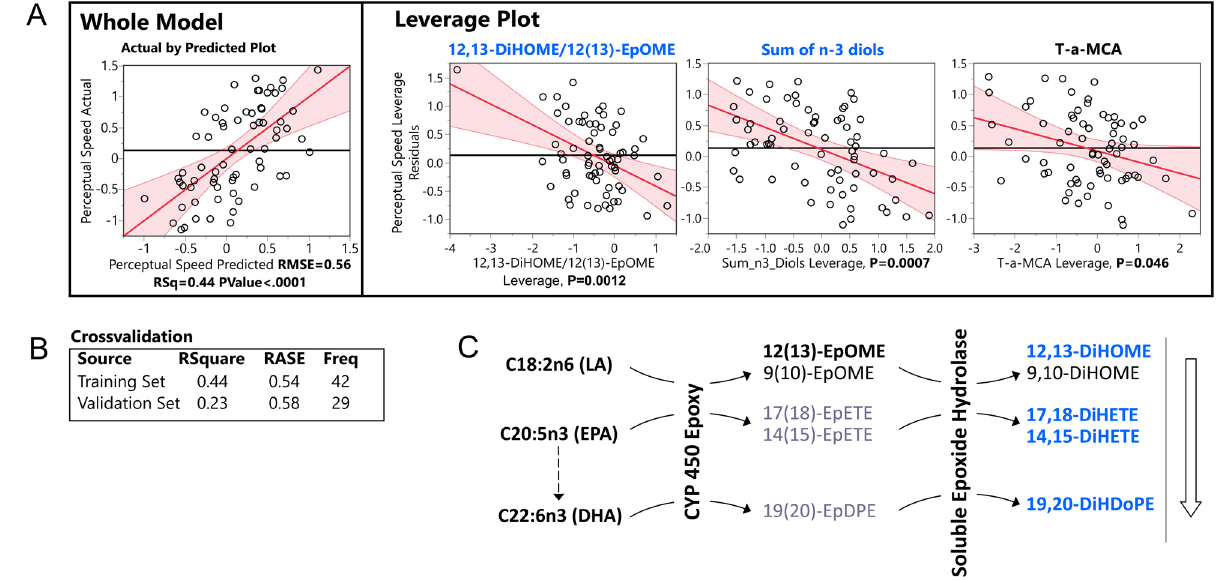
Figure 3. Least square regression model of perceptual speed. ( A ) Actual by predicted plot of a whole model and leverage plots of model components. ( B ) Model cross-validation statistics using training set (60%, n = 44) and validation set (40%, n = 33). ( C ) Model components of soluble epoxide hydrolase metabolism projected onto their metabolic pathway. Metabolic pathway starts with the fatty acids on the left, farther, metabolizing enzymes are indicated on the arrows. Multiple possible metabolites of the pathway are indicated. Metabolites of sEH used for the model are highlighted. Color of the metabolites as well as an arrow next to the metabolic pathway represents directionality of the correlation with perceptual speed (orange—positive, blue—negative). RMSE root mean squared error, LA linoleic acid, CYP 450 cytochrome p450, sEH soluble epoxide hydrolase, EpOME